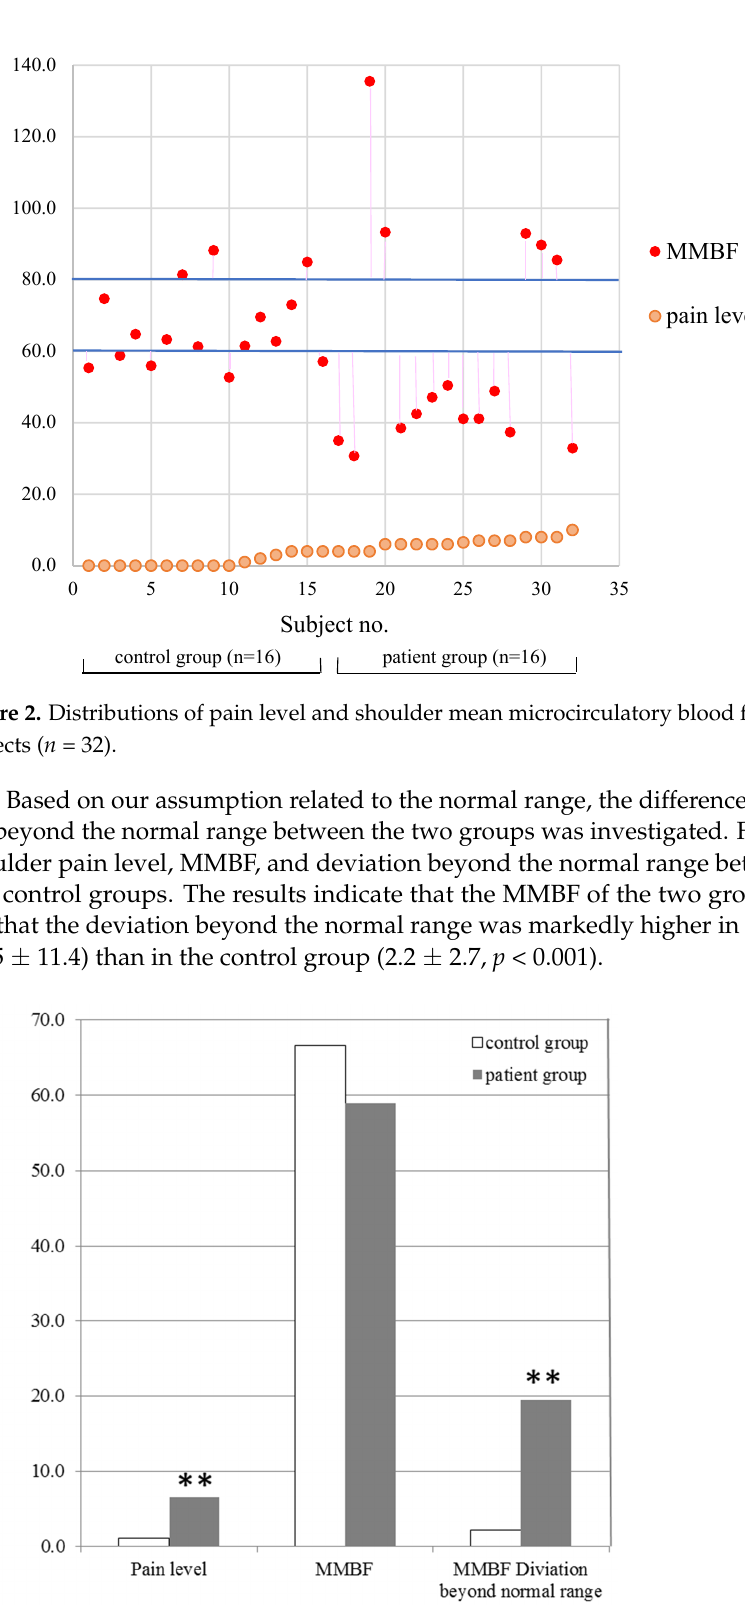
Figure 3. Comparisons of the shoulder pain level, MMBF, and deviation from the normal range (>80 or <60) between the patient and control groups (** p <